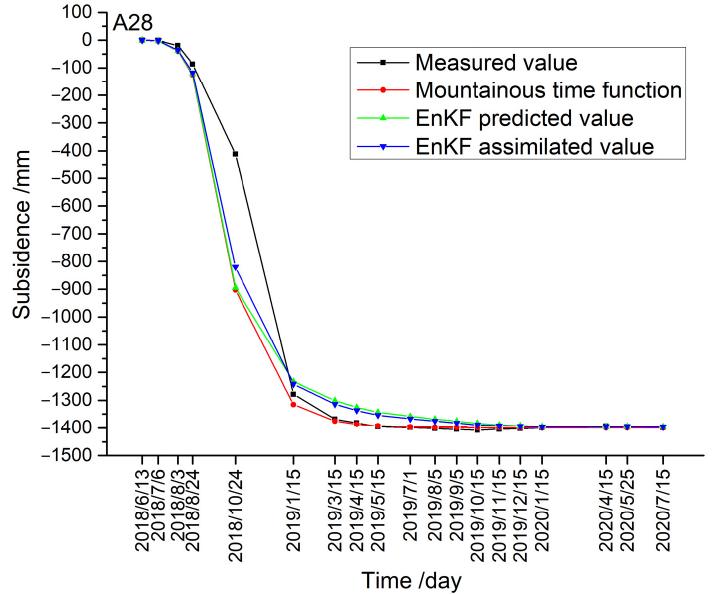
Figure 7. Subsidence curves of A28 using different methods.